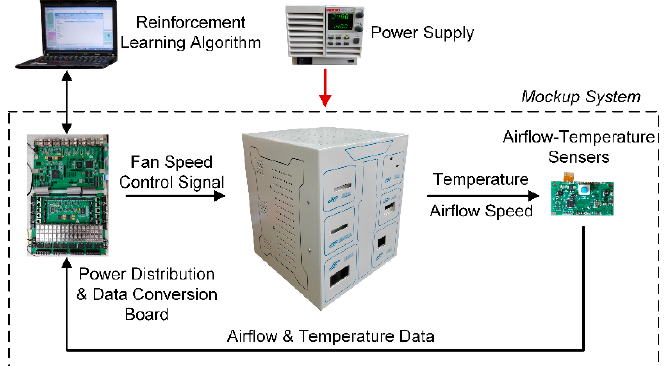
Figure 7. Schematic diagram of the experiment system.